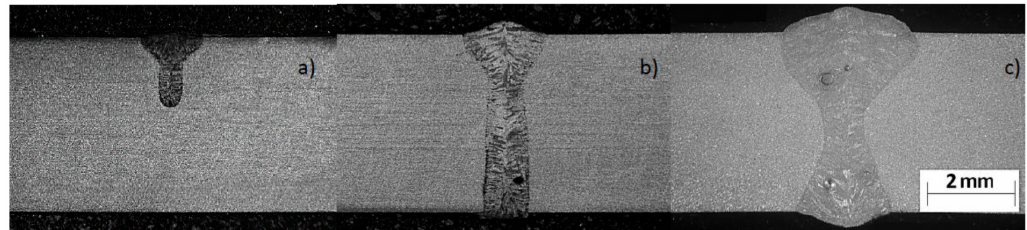
Figure 4. Examples of macrographs performed with disc laser welding ( a ) with partial penetration (bell shape), and ( b ) and ( c ) with full penetration (with a narrow and wide root known as the hourglass